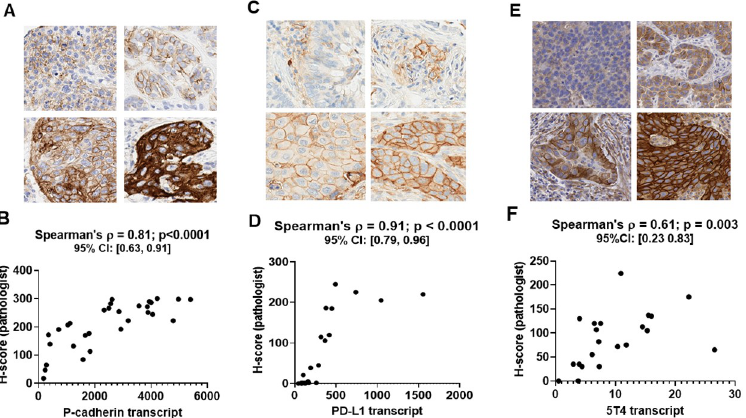
Fig 2. P-cadherin, PD-L1 and 5T4 IHC datasets. Panels A, C and E show representative images at 20x magnification with varying levels of P-cadherin, PD-L1 and 5T4 expression, respectively, in tumor resections. Panels B, D and F